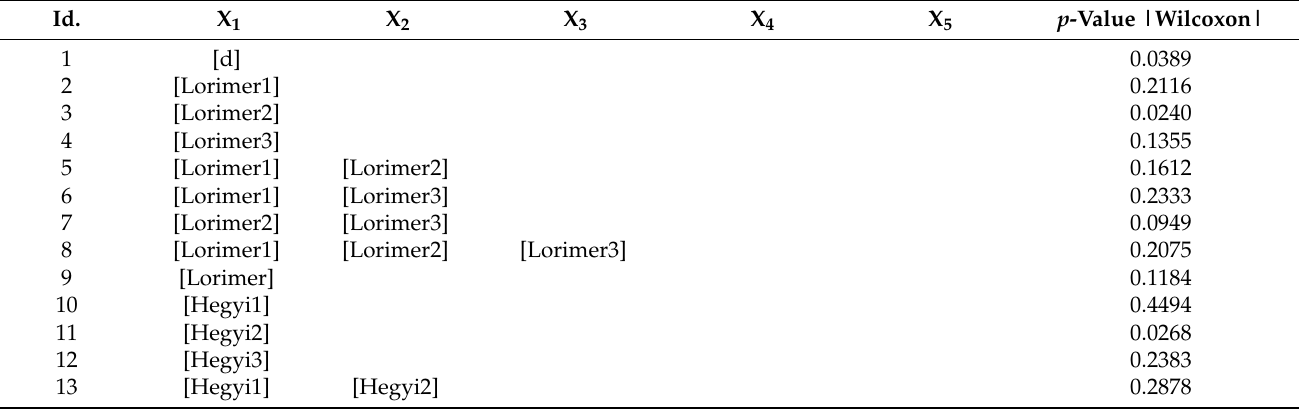
Table 7. Validation of the ANNs for A. angustifolia BAI in a mixed ombrophilous forest in Southern Brazil.